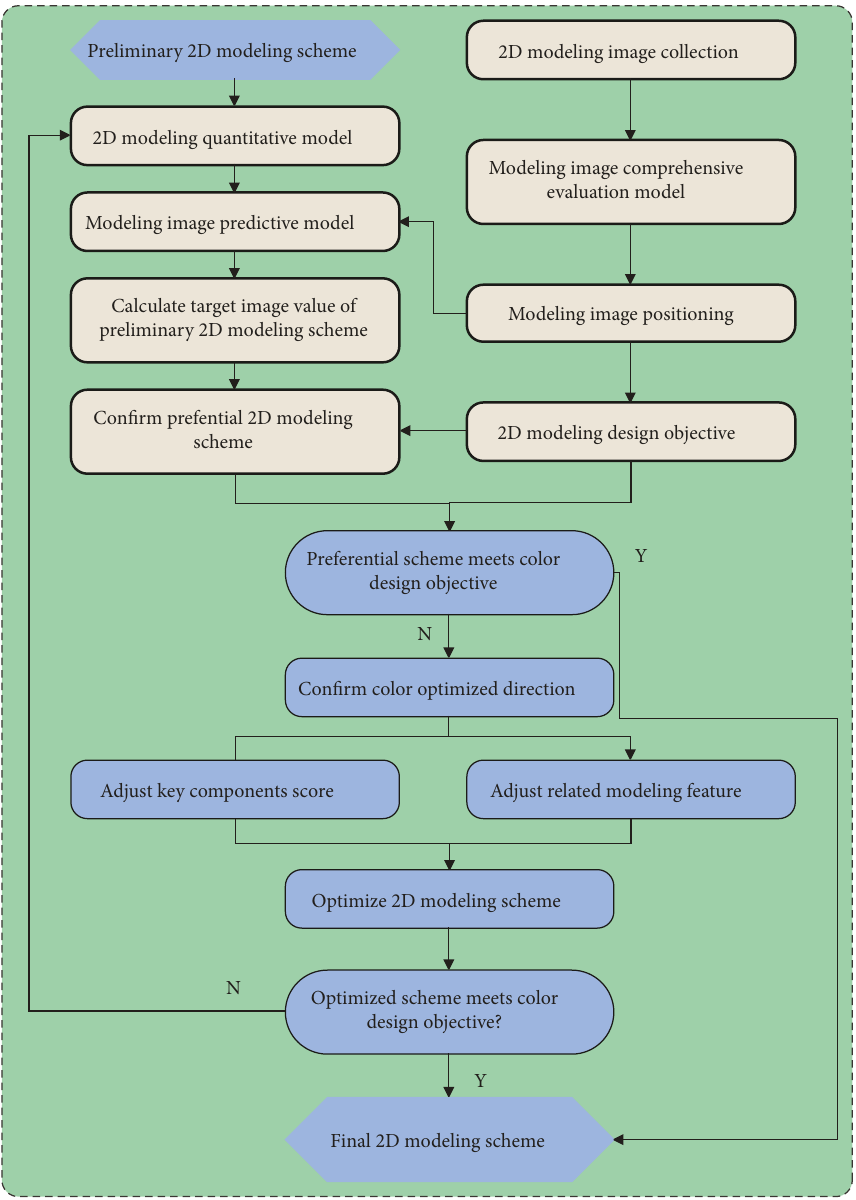
Figure 2: Modeling generation and evaluation